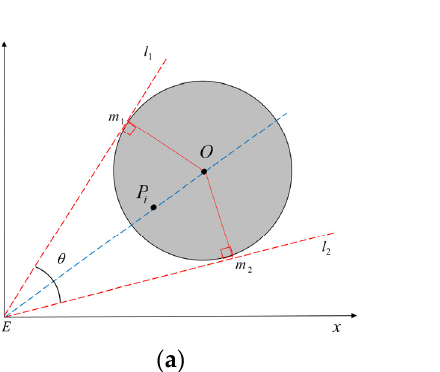
Figure 1. Encircled formation of the pursuers around the evader. ( a ) Apollonius Circle. ( b ) Complete encirclement pattern.